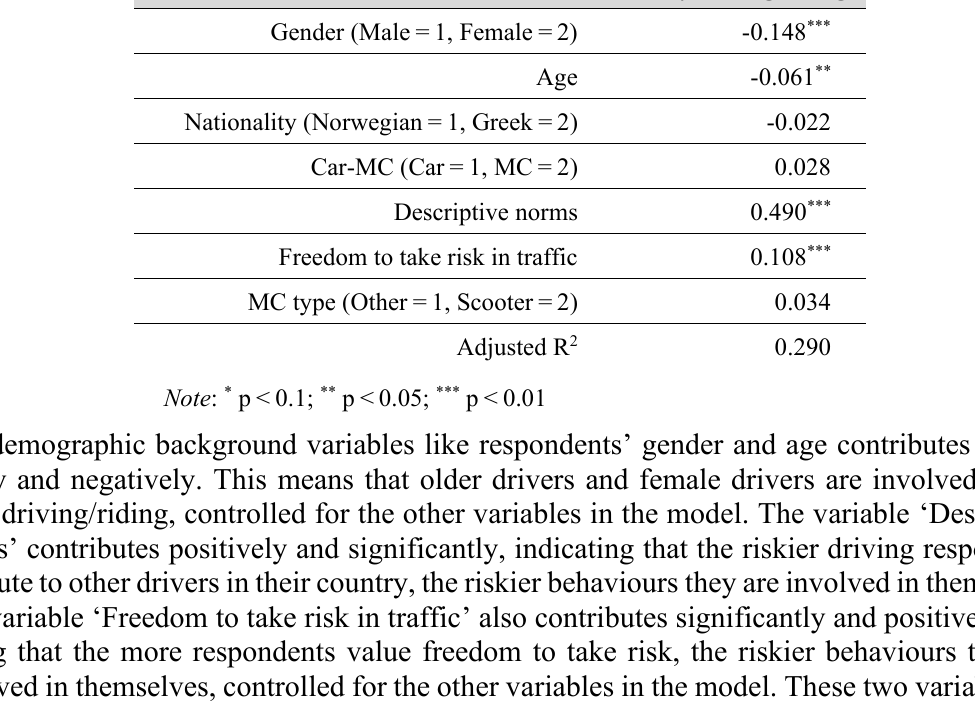
Table 5 Linear regression, standardized beta coefficients; dependent variable: ‘ Risky driving/riding ’